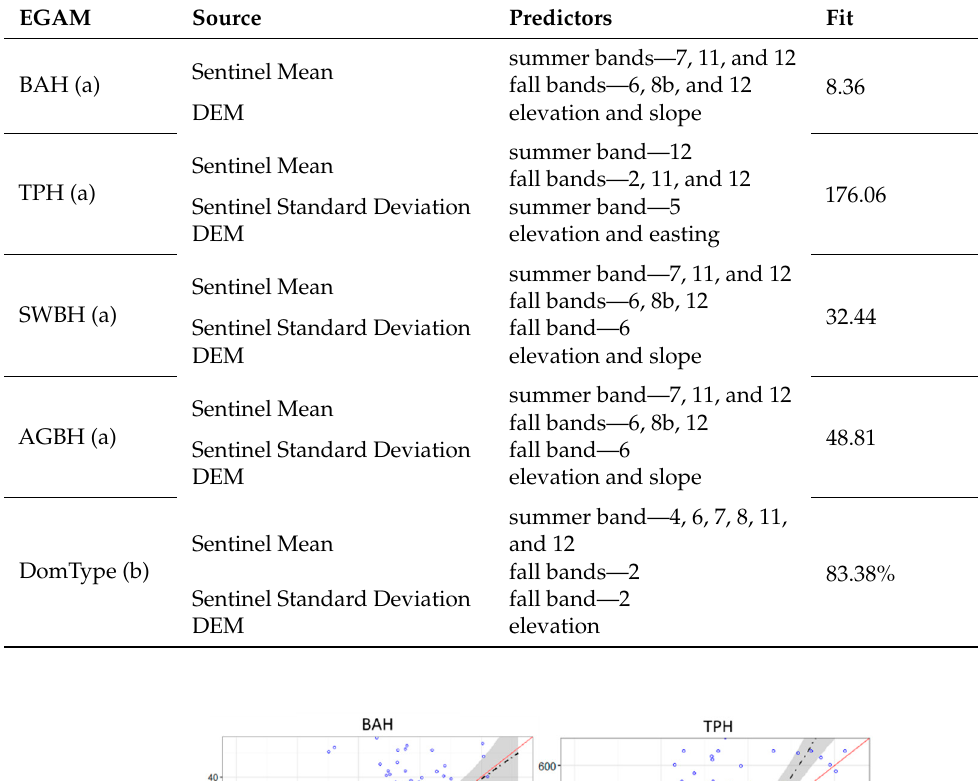
Table 7. Ensemble of generalized additive models (EGAM) predictor variables and fit statistics using all observations. Root mean squared error and overall map accuracy are reported for continuous (a) and categorical (b) response variables.